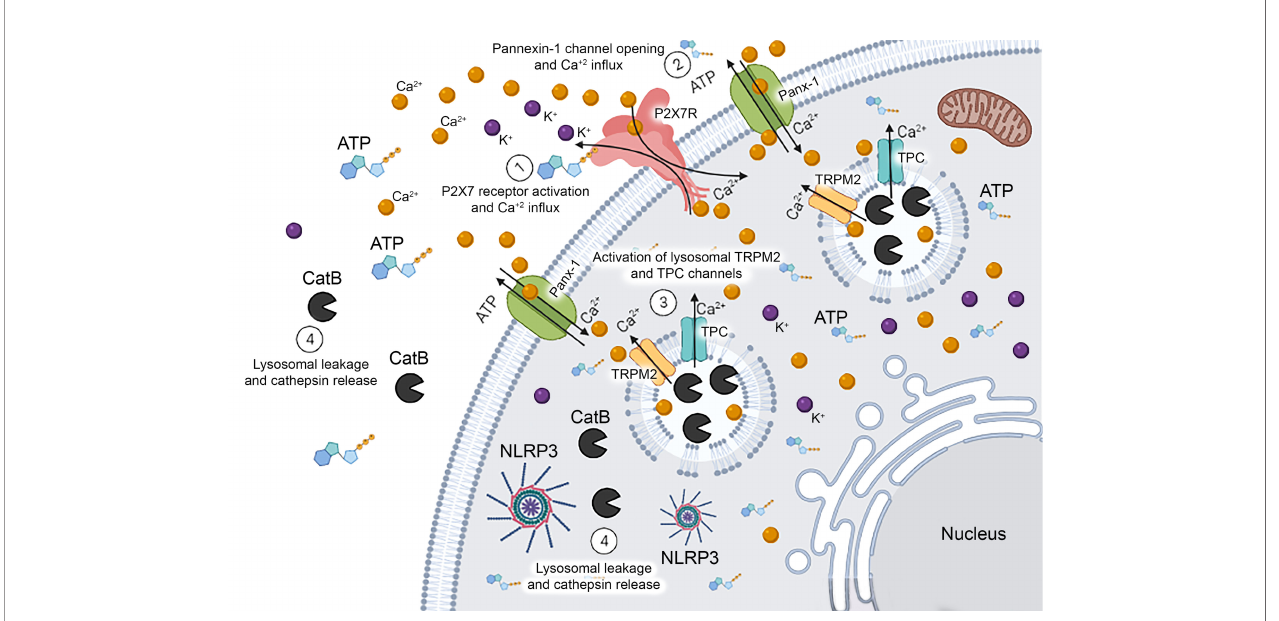
FIGURE 6 | Schematic Representation of Mechanisms Related to Endolysosomal Leakage Induced by P2X7 Receptor Activation. Extracellular ATP activates the P2X7 receptor triggering the opening of the pannexin-1 pore and causing calcium in fl ux. The increase in intracellular calcium concentration might activate TRPM2 and TPC endolysosomal calcium channels inducing the leakage of this organelle and cathepsin B release into the cytoplasm. This protease can activate NLRP3 in fl ammasome contributing to the release of pro-in fl ammatory cytokines in